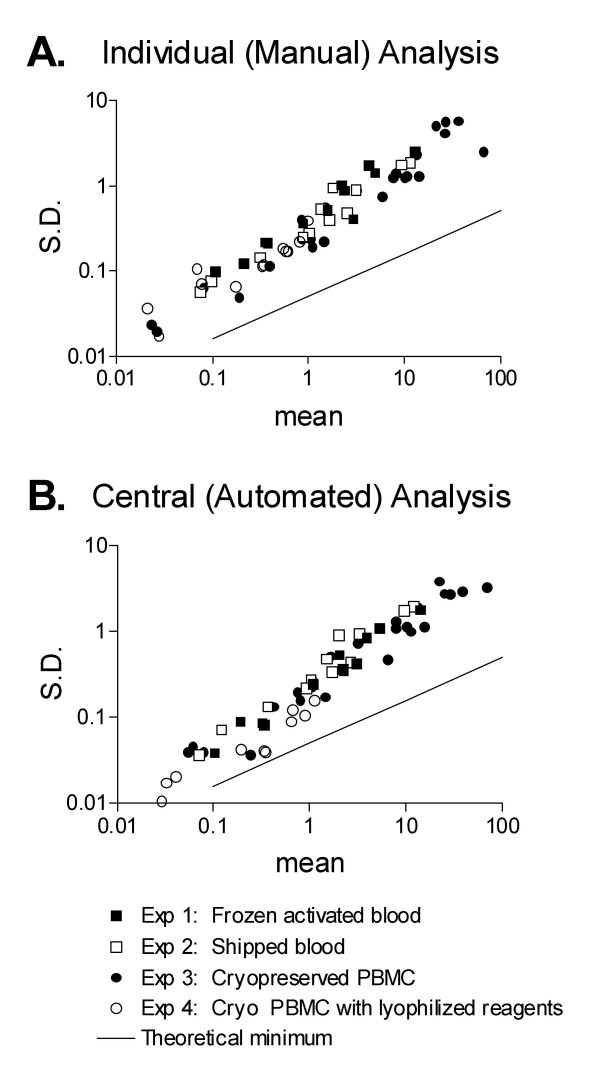
S.D. versus mean for all assays. A linear relationship between S.D. and mean is expected based upon counting statistics [23]. This expected relationship (for a data set of 40,000 events) is shown by the solid black line. The actual data from the four experiments is shown in the symbols. Data from experiment 4 are for cocktails 2 and 3 only, to be comparable with experiments 1–3. The difference (in the Y dimension) between the data points and the solid line represents variability from sources other than counting statistics. Note that the data points for all three assay types cluster together, indicating that variability is similar for all three assay types. When individual analysis variability is removed (B), there is a slight tendency toward lower variability with cryopreserved PBMC (solid circles), and higher variability with shipped whole blood (open squares). The tendency toward lower variability is more pronounced in the experiment using cryopreserved PBMC with lyophilised reagents (panel B, open circles).